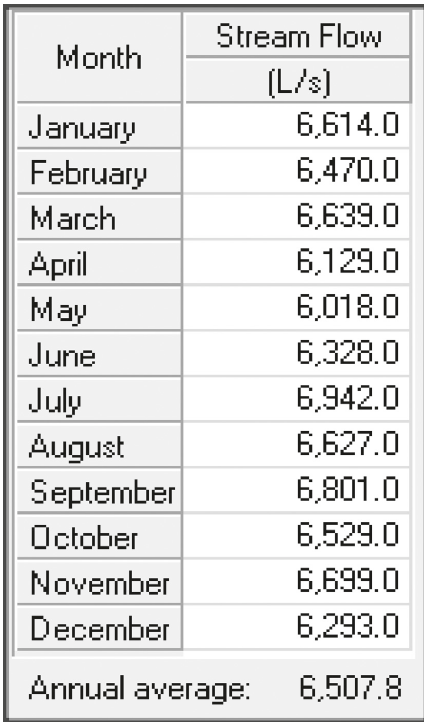
Figure 13: Monthly hydro flow rates in one year at the Ancol Bligo irrigation canal, Magelang, Central